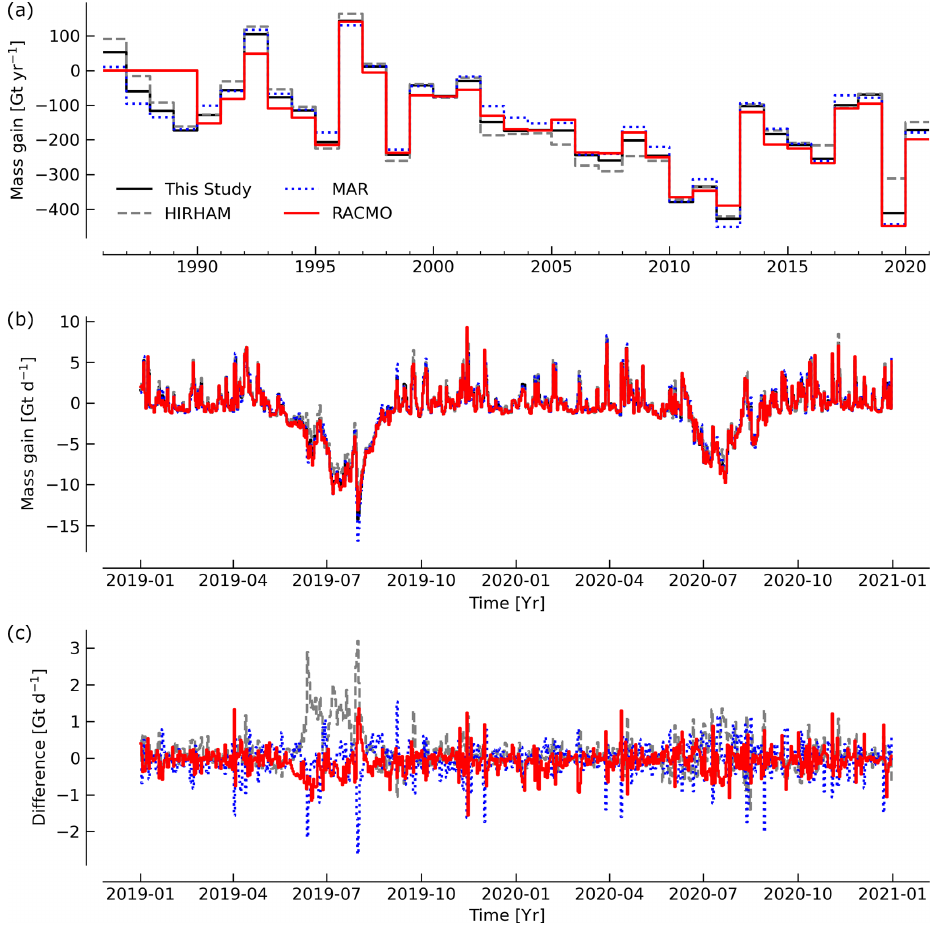
Figure A1. Comparison of This Study combined RCM product and the HIRHAM/HARMONIE, MAR, and RACMO RCMs. Results shown here are MB, not SMB, but the same D and BMB have been subtracted from each SMB product. (a) Annual MB for the entire time series. (b) Example 2 years (2019 and 2020) at daily resolution. (c) Difference between the three RCM MB products and This Study RCM-averaged product for the same data shown in panel (b)